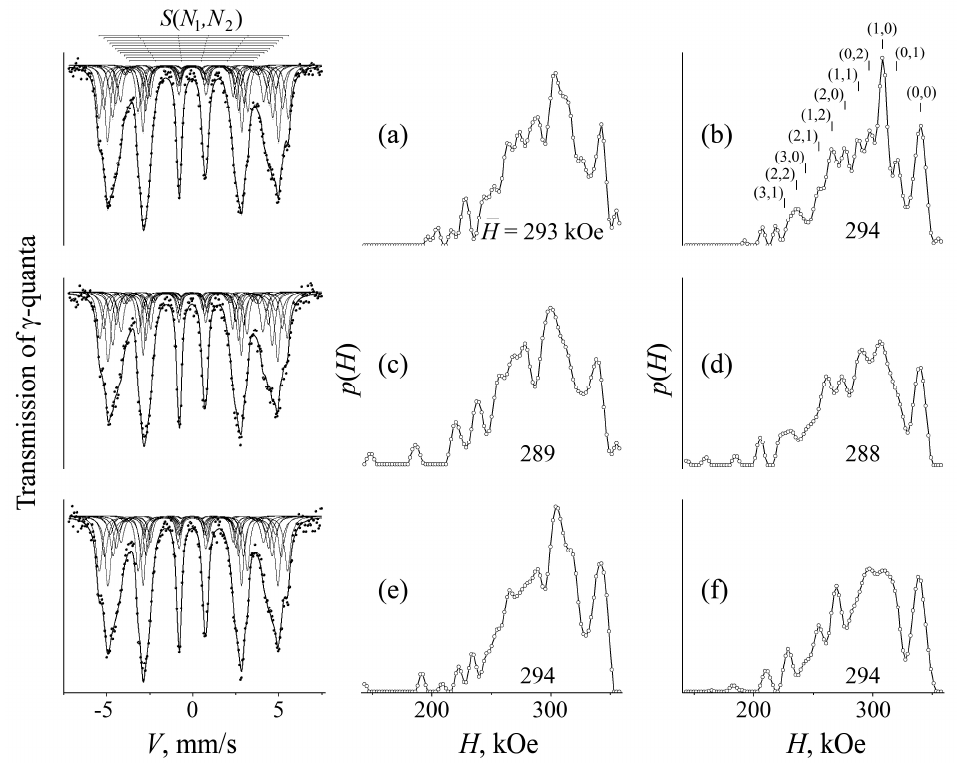
Figure 2. Spectra, distributions p ( H ), and H for the alloy Fe 86.8 Cr 13.2 . Treatment (state): ( a ) annealed at 1073 K (as-received); ( b ) annealed at 773 K, 50 h (aged); ( c ) as-received and high pressure torsion (HPT) at 80 K; ( d ) aged and HPT at 80 K; ( e ) as-received and HPT at 573 K; ( f ) aged and HPT at 573 K. The p ( H ) and H are shown only for the annealed alloy. (b) (shown) positions of the hyperfine fields corresponding to the surroundings ( N 1 , N 2